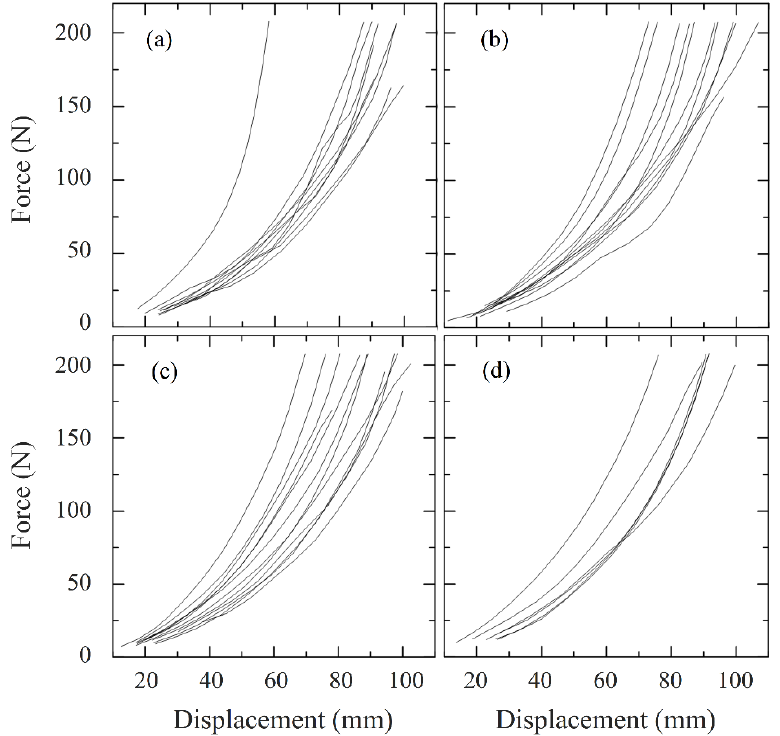
Figure 5. Applied force versus paddle displacement for breast models of ( a ) 200–400, ( b ) 400–600, ( c ) 600–800, and ( d ) 800–1400 mL.